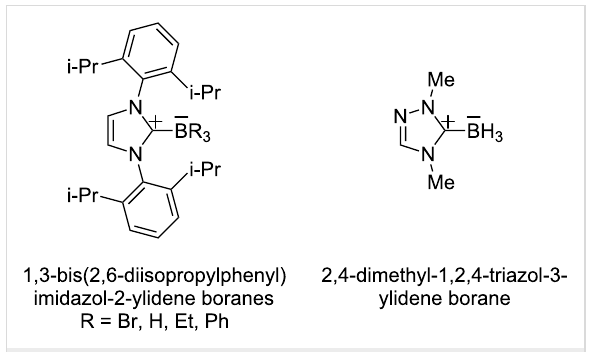
Figure 1: Representative complexes of N -heterocyclic carbenes and boranes (NHC–boranes).